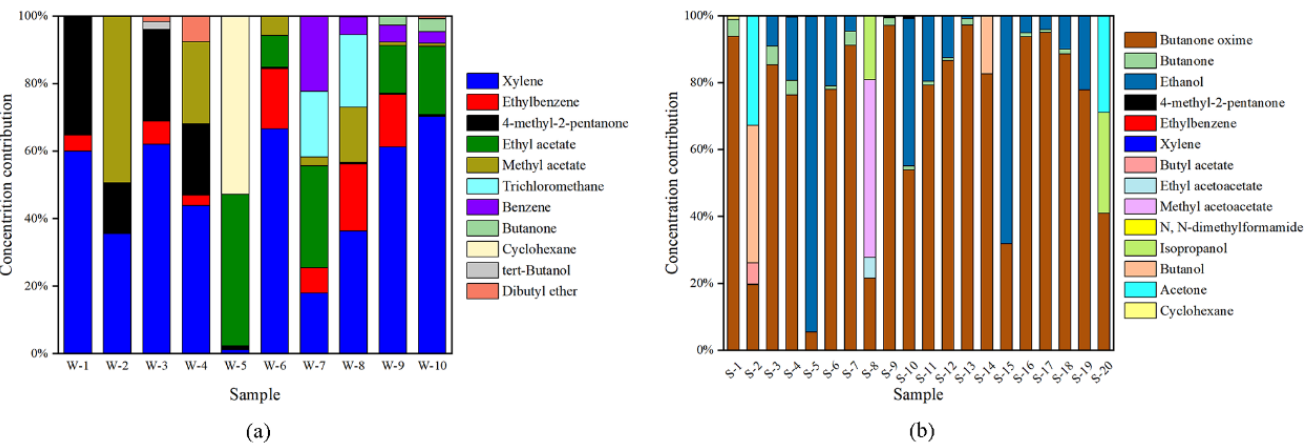
Figure 2. The concentration contribution of volatile compounds emitted from white emulsion adhe ‐ sives ( a ) and silicone adhesives ( b